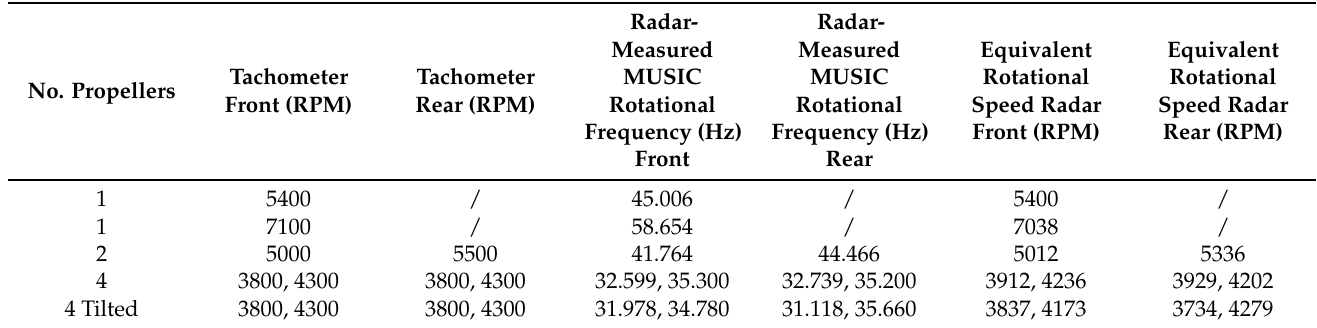
Table A2. Results obtained with a MUSIC signal subspace of thirty two.